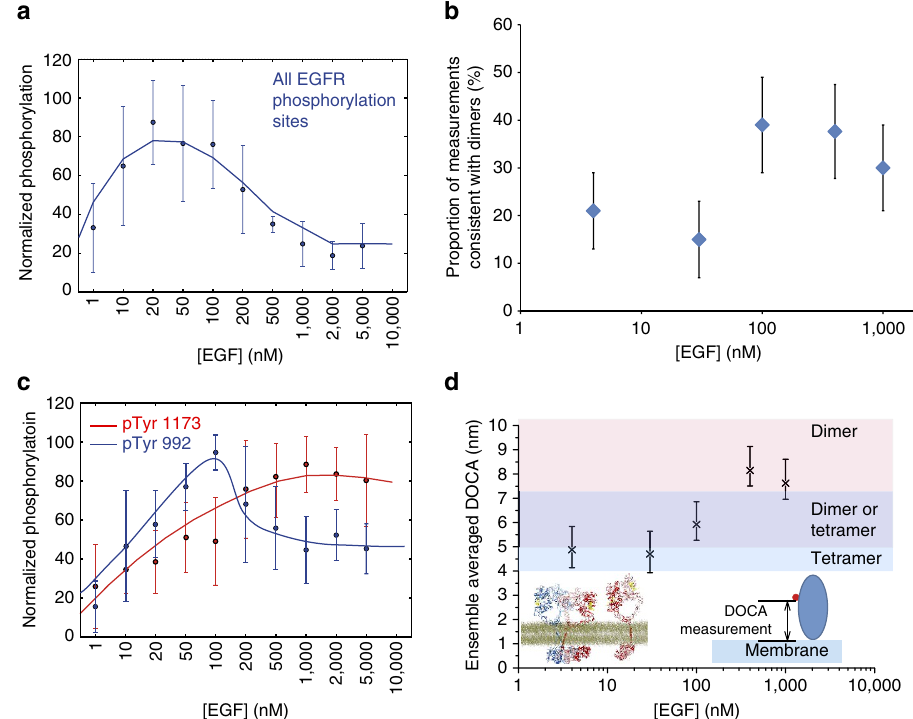
Figure 4 | Dependence of EGFR phosphorylation and oligomerization-related structural parameters on ligand concentration. ( a ) Western blot measurement of wild type total EGFR auto-phosphorylation in CHO cells exposed to increasing concentrations of EGF. The monoclonal pan-phosphotyrosine antibody 4G10 was used in the measurements. Data points and standard deviations are derived from the average of three independent measurements (examples western blot images shown in Supplementary Fig. 6c). ( b ) Similar to Fig. 3e, estimate of the relative population of EGFR dimers. The estimates are based on the wild-type FLImP distributions at varying EGF concentrations (Fig. 3e and Supplementary Fig. 7). Errors are calculated as in Fig. 3. ( c ) Western blot measurements of phosphorylation of Tyr1173 and Tyr992 in CHO cells exposed to increasing EGF concentrations. Data points and error bars (s.d.) are derived from the average of four independent measurements (examples shown in Supplementary Fig. 6a,b). For the Tyr992 data, P values were calculated using Student’s t -test to determine whether measured phosphorylation at high EGF concentrations was significantly different from the maximum phosphorylation value measured at 100nM EGF. P values are: 50nM EGF, P ¼ 0.058; 200nM EGF, P ¼ 0.173; 500nM EGF, P ¼ 0.027; 1,000nM EGF, measurements shown in Supplementary Fig. 8. DOCAs were obtained from 1,000 bootstrap data sets (that is, data sets resampled with replacement). The error bars are the standard deviations of the bootstrap means. Simulations of the tetramer (Fig. 2d and Supplementary Fig. 5c) and dimer 9 (bottom left inset) predict a DOCA of B 5nm for oligomers and B 7.5nm for